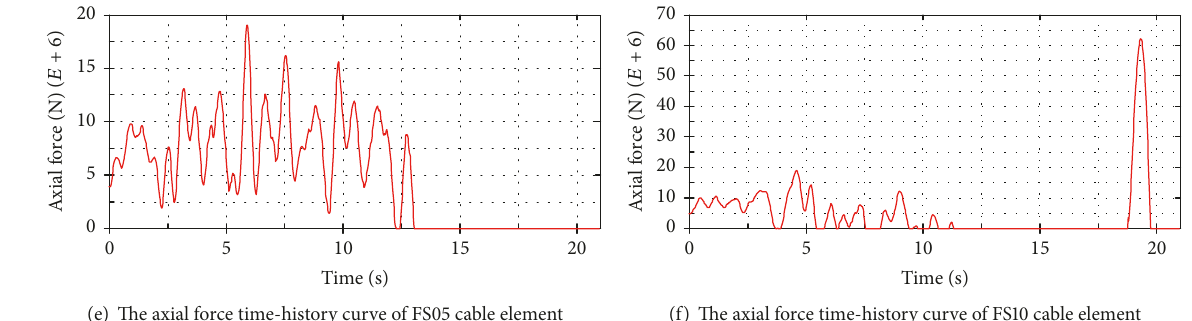
(f) The axial force time-history curve of FS10 cable element Figure 13: Time-history curves of moment and axial force for